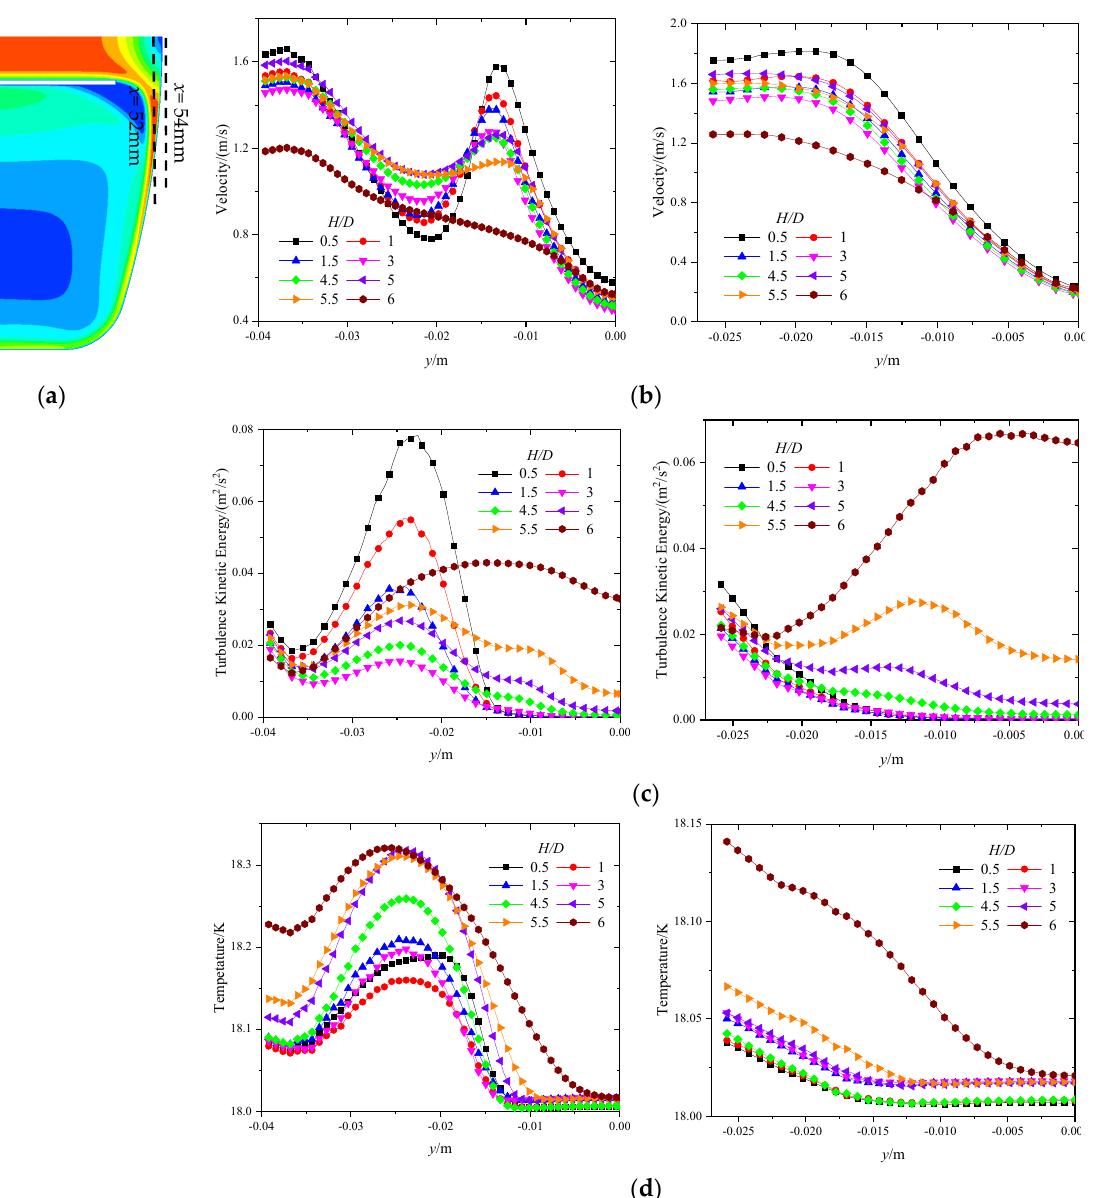
Figure 15. Different physical quantities radial distribution along different H/D (Left, x = 52 mm; Right, x = 54 mm): ( a ) Schematic of the position; ( b ) Velocity; ( c ) Turbulent kinetic energy; ( d ) Temperature. To explore the influence of distance H/D on temperature distribution of CHM in detail, the current work analyzes the changes of liquid hydrogen and wall temperature gradient along radial and axial directions. At the same time, since beam power plays an important role in the change of temperature gradient and temperature value, four representative sections are selected for discussion, that is, the temperature gradient changes significantly, including x = 0 mm, x = − 45 mm, y = − 30 mm and y = − 75 mm, as shown in Figure 16.